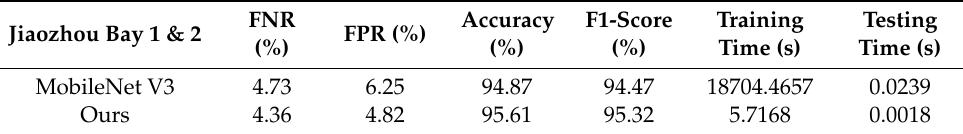
Table 4. Sand wave detection performance on Jiaozhou Bay 1&2.